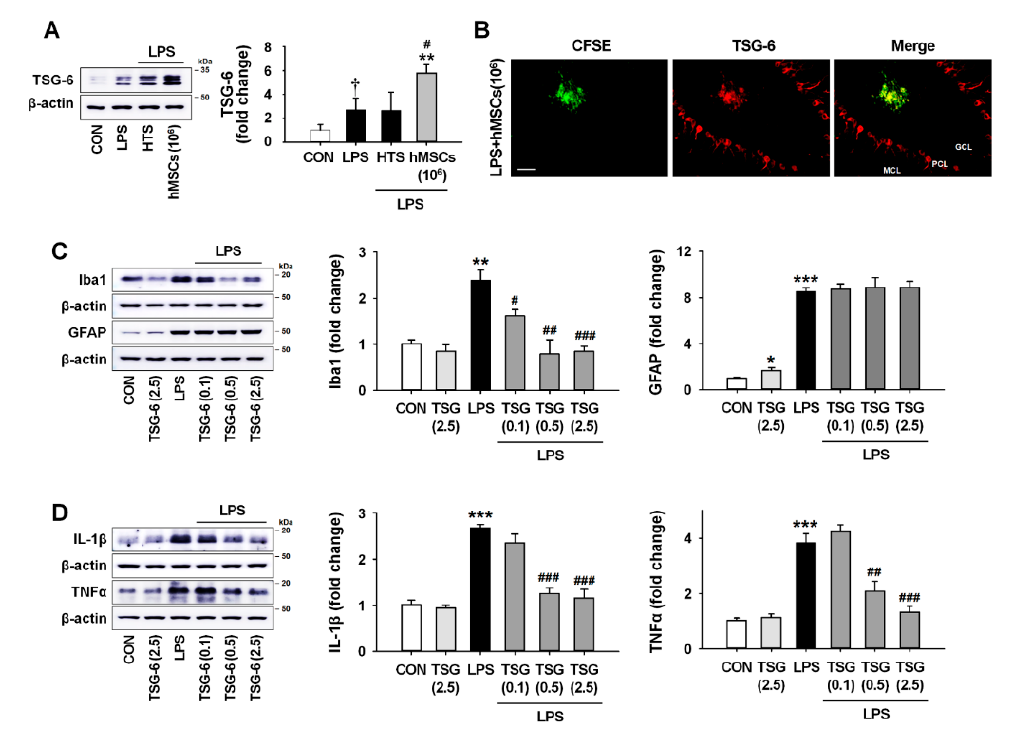
Figure 5. The anti-inflammatory effects of hMSCs-derived TSG-6 in LPS-exposed cerebellum. ( A ) The expression levels of TSG-6 in the LPS-exposed cerebellum 7 days after hMSC transplantation. ** p < 0.01 vs. CON and # p < 0.05 vs. LPS ( n = 3 per group) and † p < 0.05 vs. CON (two-sided paired t-test analysis; n = 3 per group). ( B ) The expression pattern of CFSE-labeled hMSCs (green) and TSG-6 (red) in the cerebellum of ICA mice 7 days after hMSC treatment (Scale bar = 50 µ m). ( C ) The expression levels of Iba1 and GFAP in the LPS-exposed cerebellum 7 days after rhTSG-6 treatment. * p < 0.05, ** p < 0.01, *** p < 0.001 vs. CON and # p < 0.05, ## p < 0.01, ### p < 0.001 vs. LPS (two-sided paired t-test analysis, n = 4 per group). ( D ) The expression levels of proinflammatory cytokines, such as IL-1 β and TNF α , in the cerebellum of ICA mice 7 days after rhTSG-6 treatment. *** p < 0.001 vs. CON and ## p = 0.01, ### p < 0.001 vs. LPS ( n = 4 per group). The images of blots were displayed in cropped format. Significance of statistical analysis was analyzed by one-way ANOVA with Tukey’s post-hoc analysis ( A , D ) and two-sided paired t-test ( C ). hMSCs, human mesenchymal stem cells;